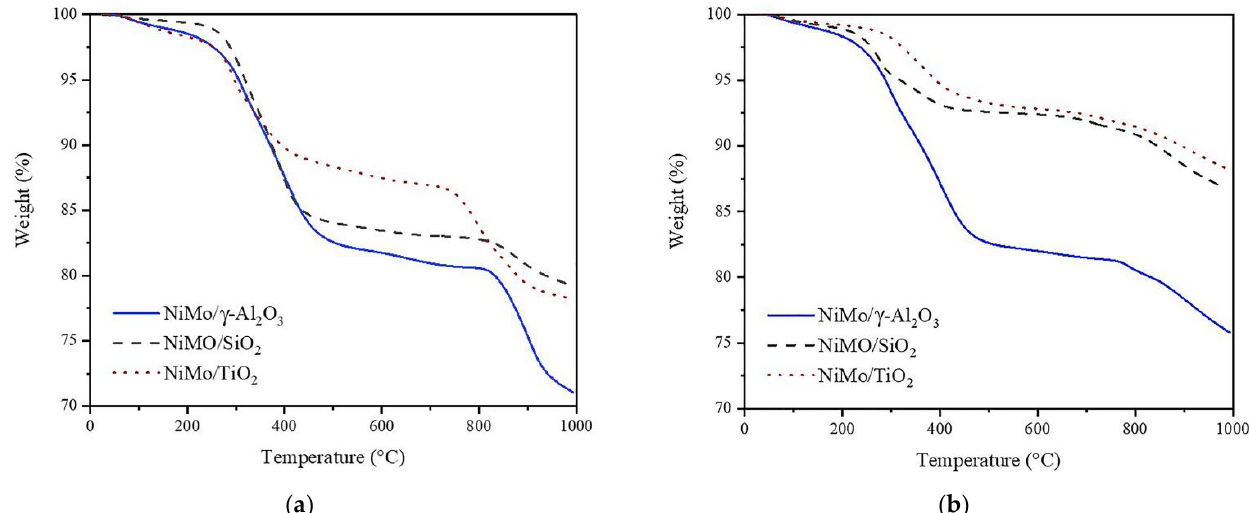
Figure 11. Thermogravimetric (TGA) as function of temperature of the spent NiMo/γ -Al 2 O 3 , NiMo/SiO 2 , and NiMo/TiO 2 catalysts used in hydrotreating of ( a ) Pongamia pinnata oil and ( b ) refined palm olein (RPO).